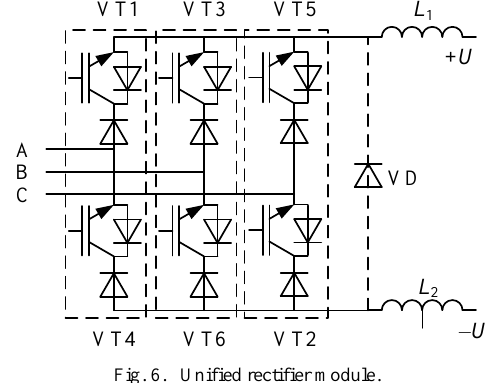
Fig. 6. Unified rectifier module.